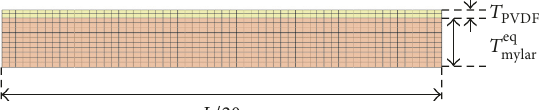
Figure 4: Details of the FE mesh discretization.